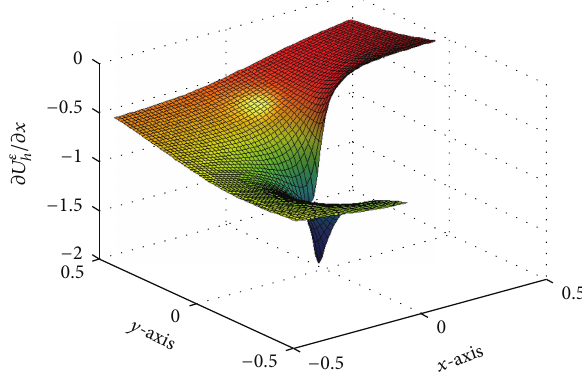
Figure 8: 𝜕𝑈 𝜀 ℎ /𝜕 𝑥 in the “singular” part.